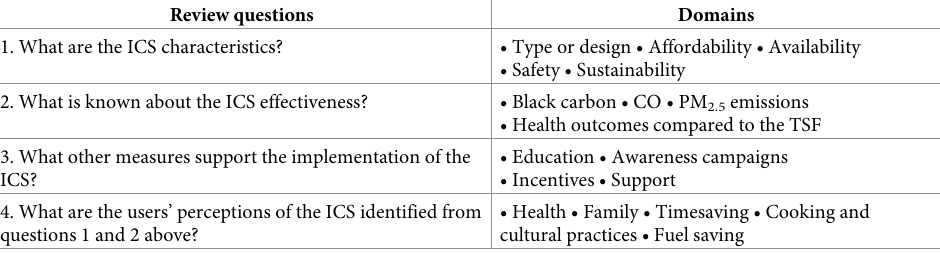
Table 1. Review questions and domains developed with JBI’s PCC and experts’